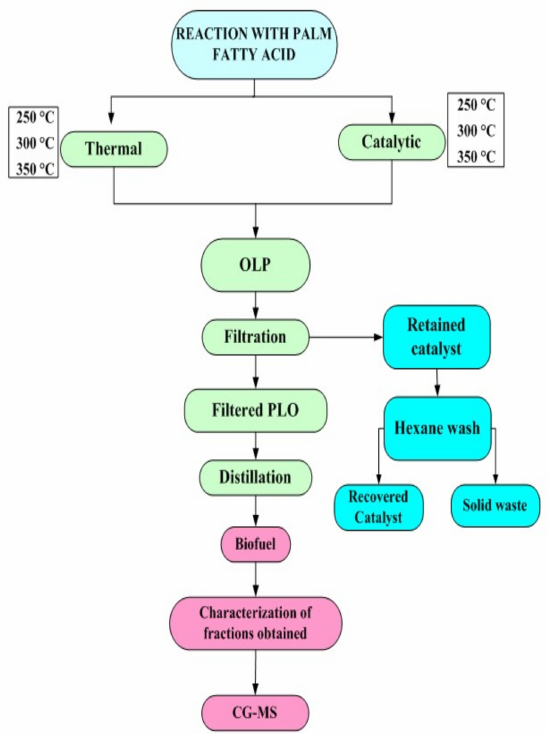
Figure 11. Scheme of separation of products and